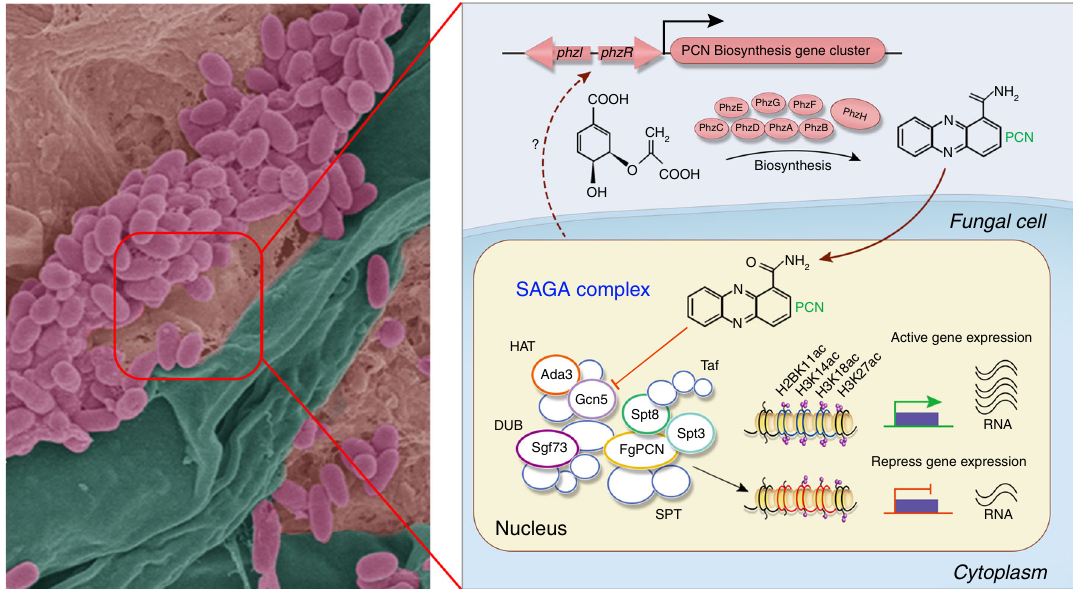
Fig. 6 A model for the mode of action of PCN in ZJU60 – Fg interactions. Bio fi lm formation of biocontrol agent P . piscium ZJU60 on the surface of fungal mycelia physically mediates the interaction between ZJU60 and Fg (left panel). Fungal mycelia, bacteria and matrix of bacterial bio fi lm are shown in green, purple, and brown, respectively, in the pseudocolor image. PCN biosynthesized by the phzA-H gene cluster is the major antifungal compound produced by ZJU60. In Fg, the SAGA complex regulates mycelium growth, deoxynivalenol (DON) biosynthesis, penetration and virulence mainly by modifying the histone acetylation of H2B11, H3K14, H3K18, and H3K27. During the interaction between ZJU60 and Fg, PCN diffuses into fungal cells and targets the SAGA complex by inhibiting the acetyltransferase activity of FgGcn5, which subsequently leads to reduced levels of histone acetylation, repression of gene expression, and suppression of fungal growth and pathogenicity. The number of purple circles on histone tails represents relative acetylated level of